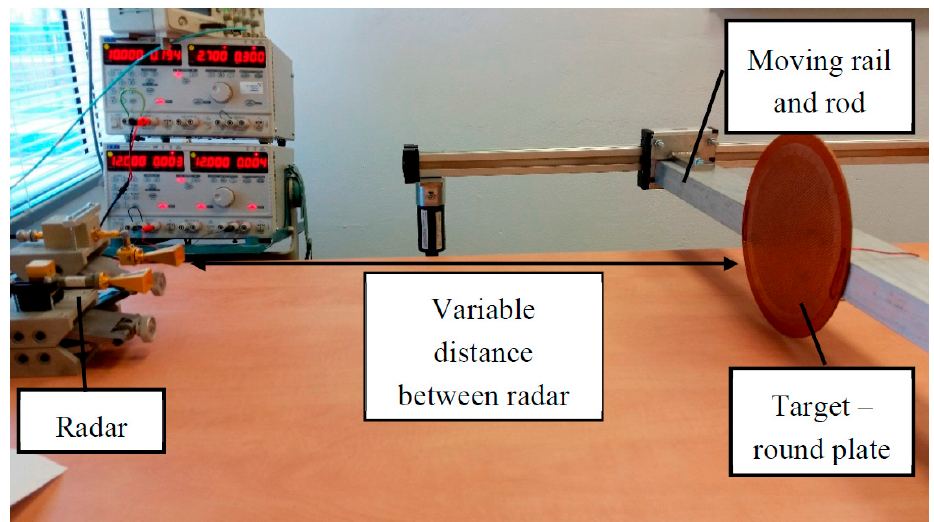
Figure 4. Multi-ray experiment setup. The transmitter and the receiver adjacent to each other.